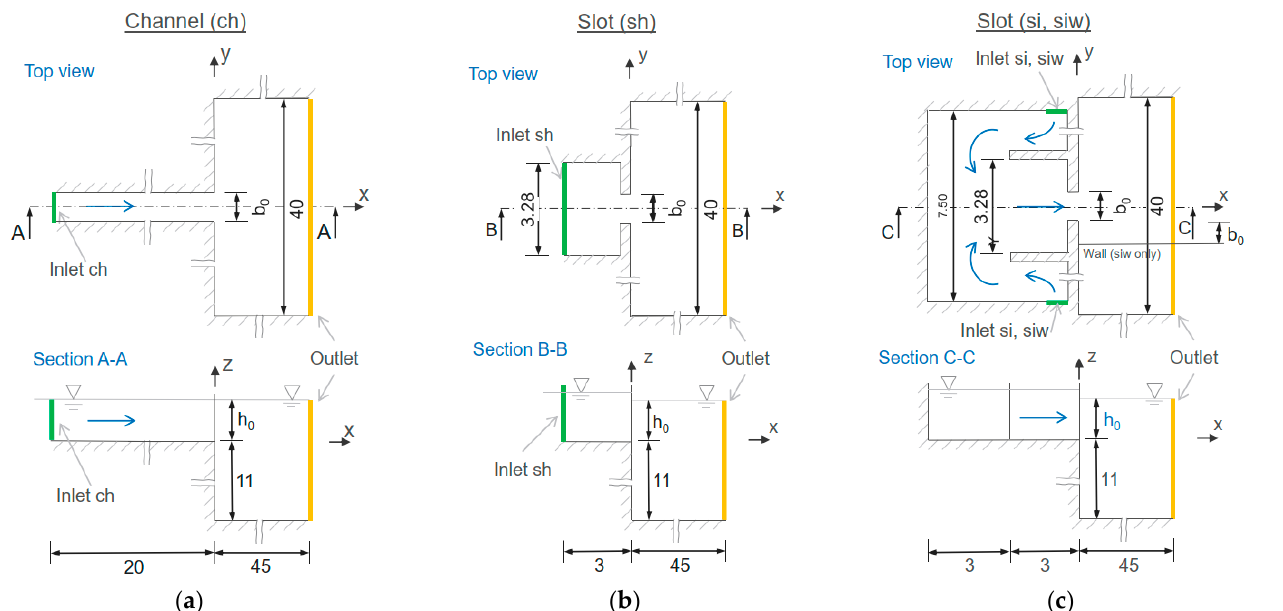
Figure 2. Top view and section of ( a ) channel orifice; ( b ) slot orifice with homogeneous approach flow; and ( c ) slot orifice with inhomogeneous approach flow and optional lateral wall. Dimensions in meters. Not to scale.